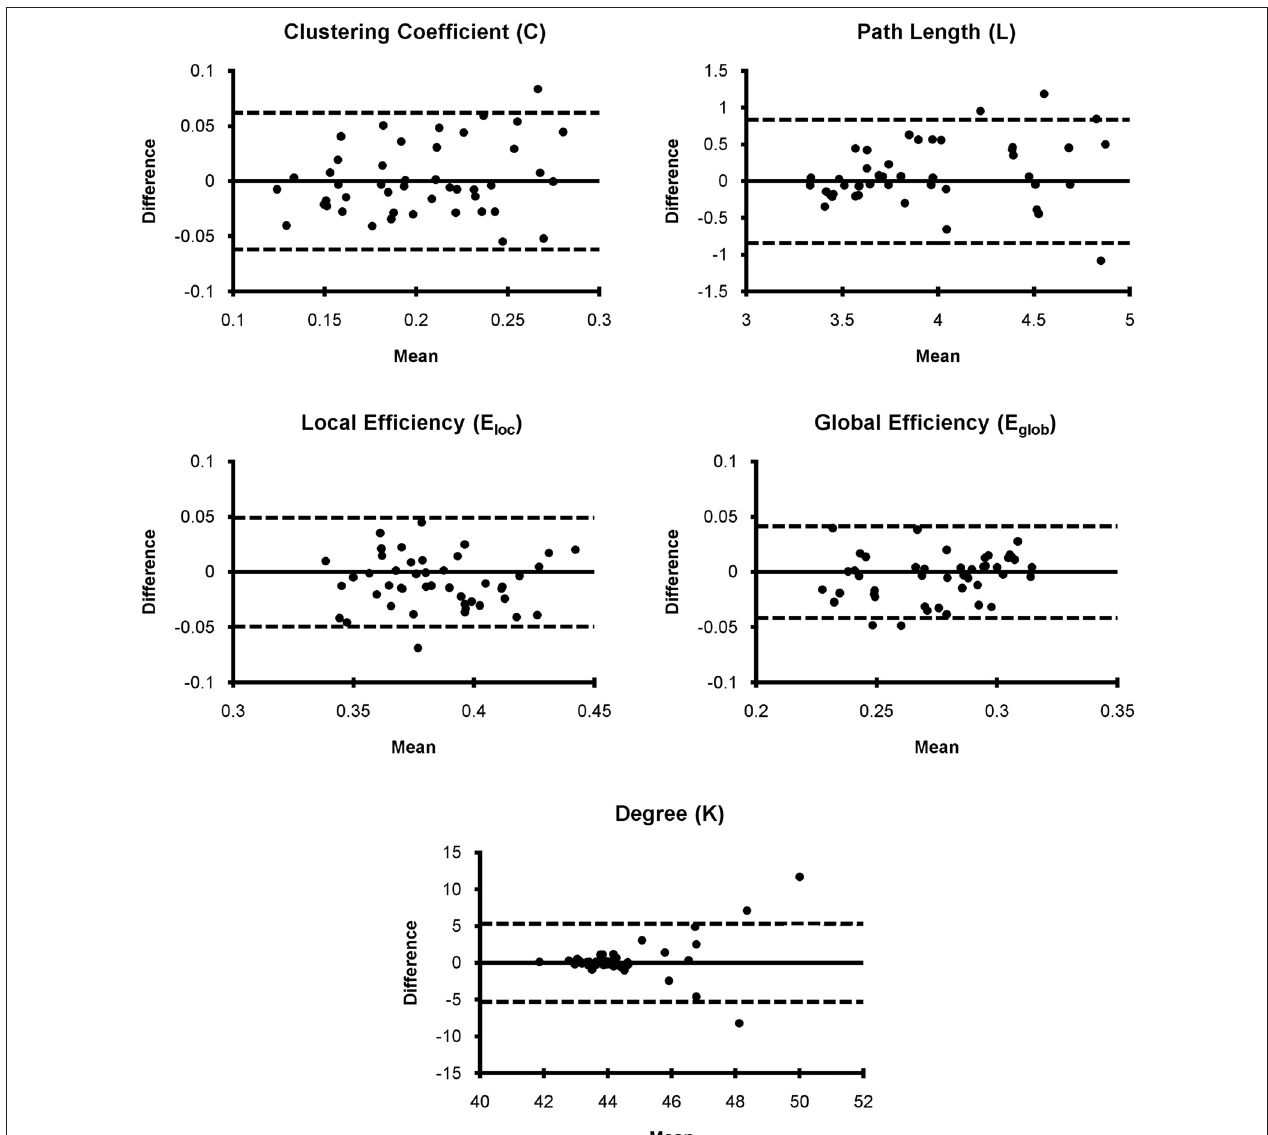
FIguRe 3 | Bland–Altman plots for network metrics. Network metric differences for each subject generally fell within the repeatability coefficient limit (dashed line) suggesting that mean network metrics are generally